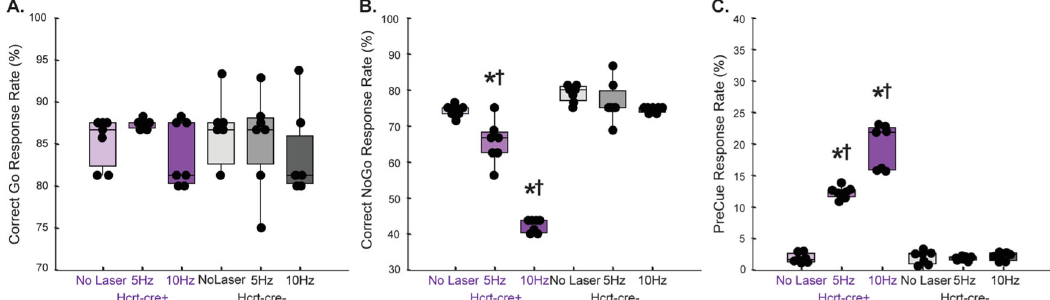
Fig. 2 Stimulating Hcrt neurons increases impulsivity. The effects of 5 or 10 Hz optogenetic stimulation of Hcrt neurons on Go/NoGo Behavior. A Hcrt stimulation has no effect on probability of a correct Go response but does ( B ) reduce probability of a correct NoGo response and ( C ) increase precue response rate. Effects are not seen in Hcrt-cre- controls (gray). Color indicates genotype and shade indicates laser frequency. *denotes difference from No- Laser control trials within the same genotype (Bonferroni ’ s test, p < 0.05) and † denotes difference from Hcrt-cre- controls at that particular laser frequency. Box plots indicate averages and standard deviation. Whiskers span maxima and minima